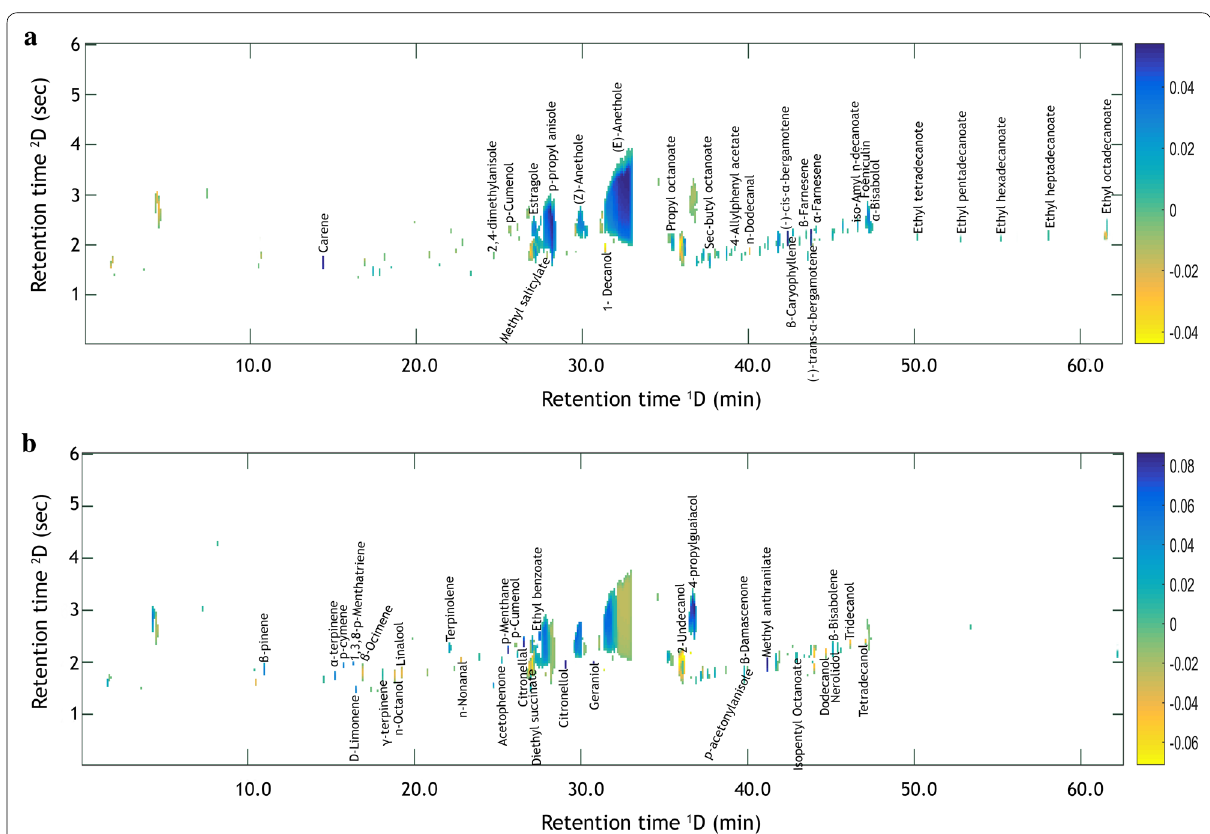
Fig. 3 a Two‑dimensional chromatographic loadings from PC1 and b